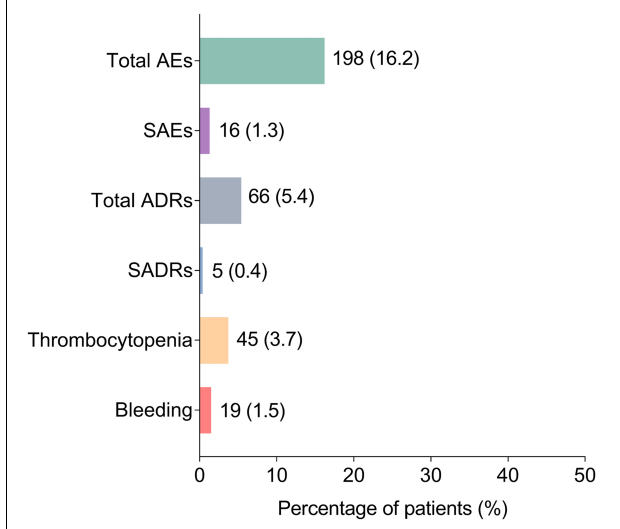
FIGURE 1 | Occurrence of AEs, SAEs, ADRs, SADRs, thrombocytopenia, and bleeding. AEs, adverse events; SAEs, severe adverse events; ADRs, adverse drug reactions; SADRs, severe adverse drug